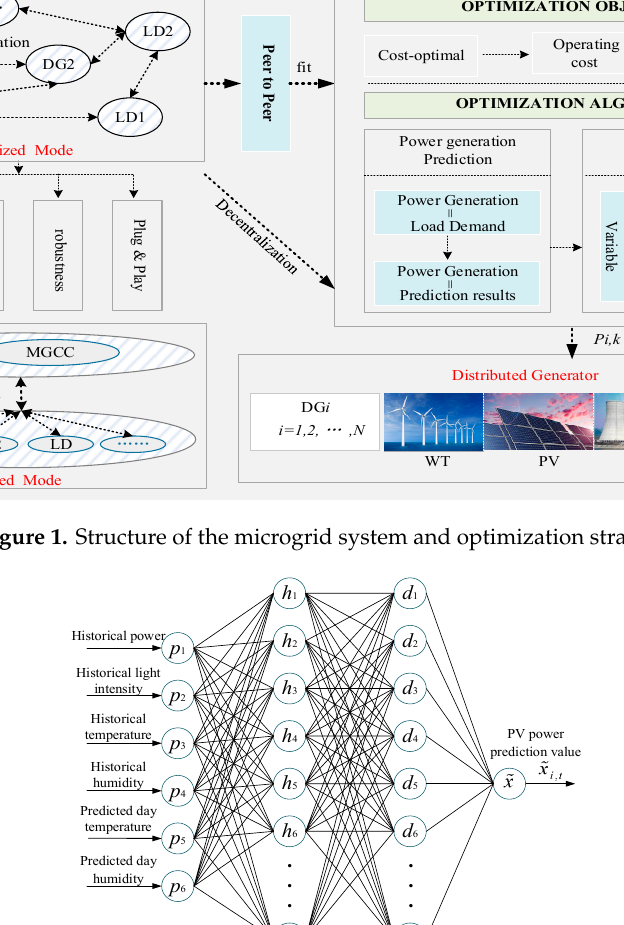
Figure 2. Neural network model for Photovoltaic (PV) power generation prediction. where (cid:101) x † represent the prediction output value. The input of model from P 1 to P 6 are historical power, light intensity, temperature, humidity and the temperature, humidity of the predicted day, respectively.